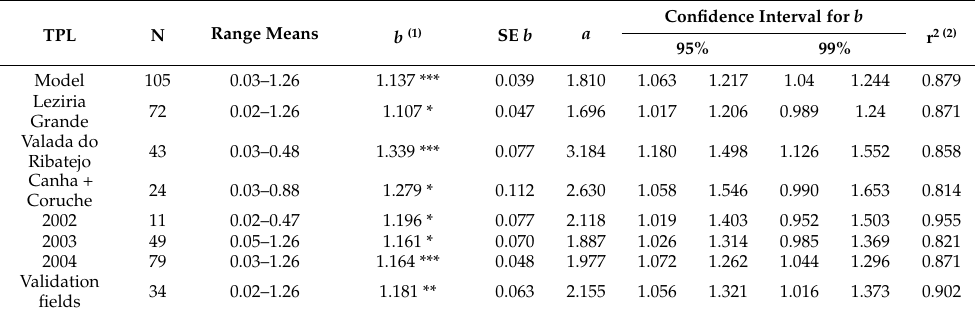
Figure 2. Taylor’s power law (TPL) regression plot for Helicoverpa armigera in processing tomato crops (the regression model was fitted by a reduced major axis regression method with 105 data sets; the line corresponds to the trend line). Table 4. Estimates of the parameters of Taylor’s power law (slope and intercept) for Helicoverpa armigera in processing tomato crops and 95% and 99% confidence intervals for the slope fitted to the data sets of the model, validation fields, and each location and year (N—sample size, SE—standard error of the mean).